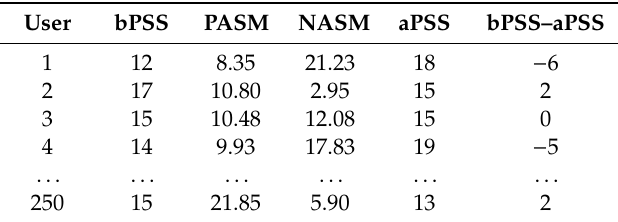
Table 1. Data composition of one week. bPSS—conventional PSS; PASM— Positive Activity for Stress Management; NASM—Negative Activity for Stress Management; aPSS— the PSS result for